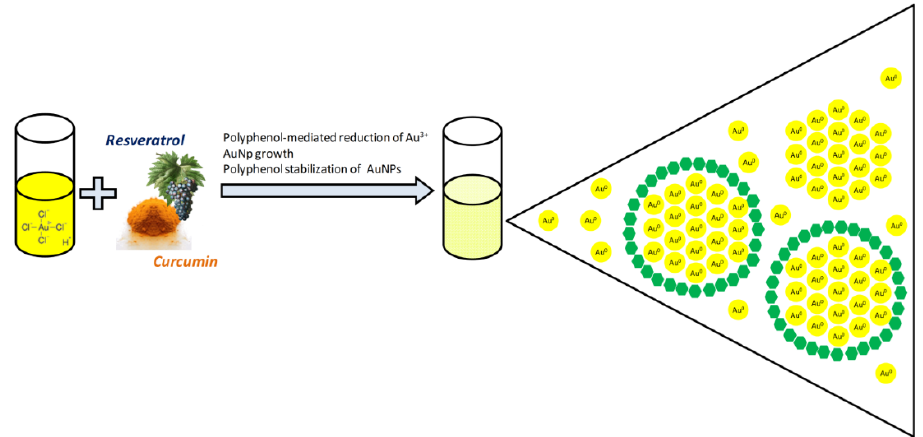
Figure 19. Schematic description of the green synthesis of AuNPs starting from chloroauric acid (HAuCl 4 ) and using Cur or Res as reducing and stabilizing agents.